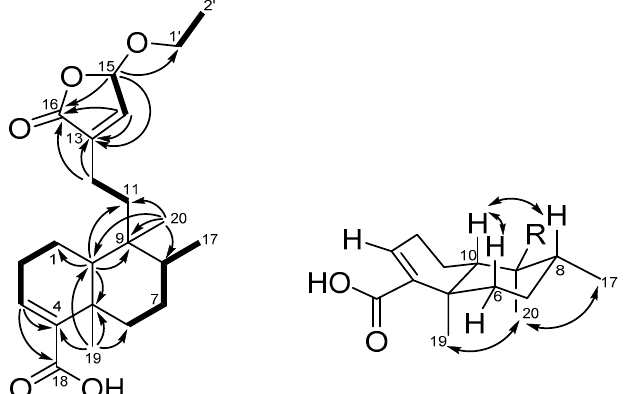
Figure 3. COSY (bold bond), selected HMBC (arrow), and NOESY (left-right arrow) correlations of compound 2.